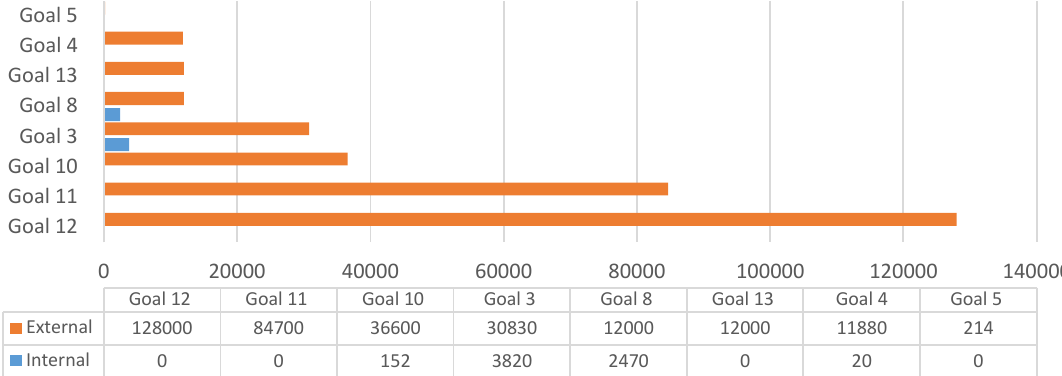
Figure 2. External and internal stakeholders engagement in SDG’